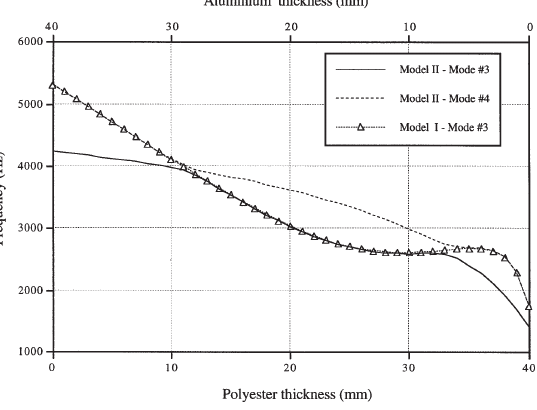
Fig. 3. The effect of thickness distribution on the modal strain energy (model